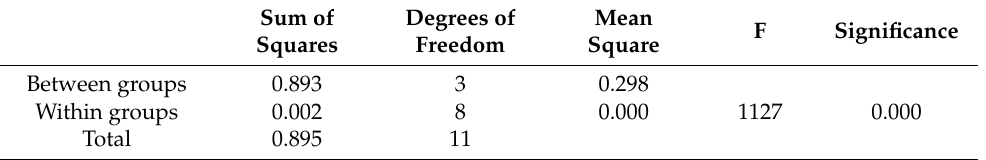
Sum of Degrees of Mean F Significance Squares Freedom Square